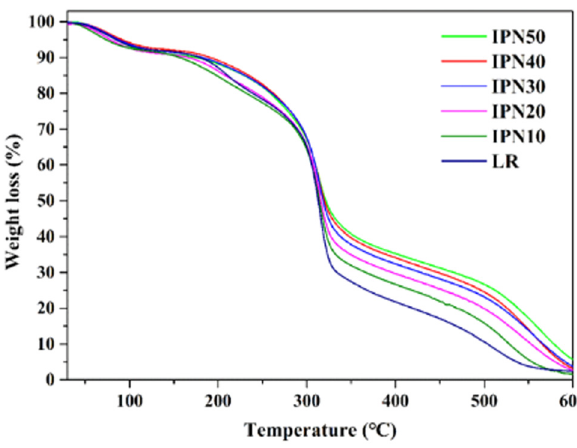
Figure 4: TGA curves of LR and IPN fi lms.